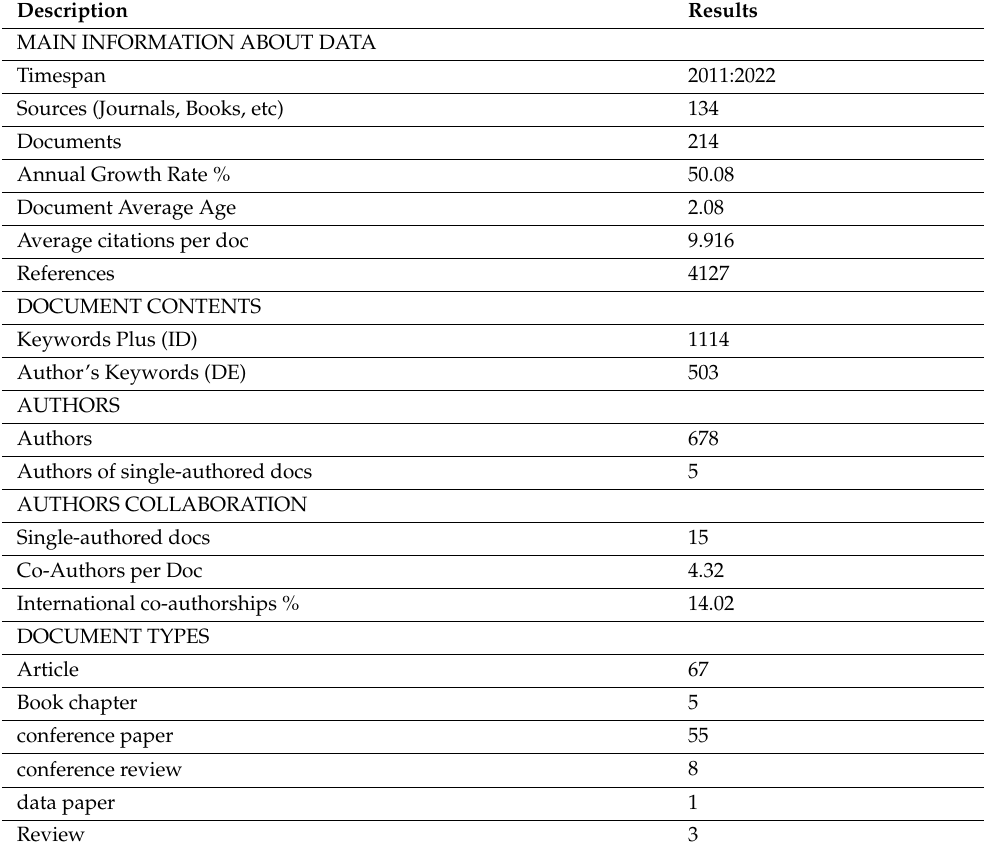
Table 1. Detailed description of the chosen dataset along with the study’s